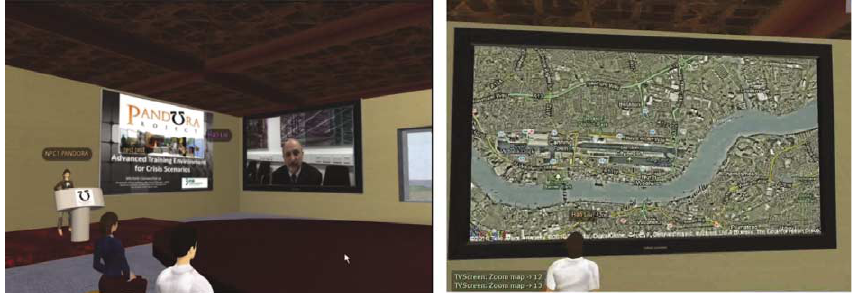
Figure 3. In-world slide show, streaming video and map